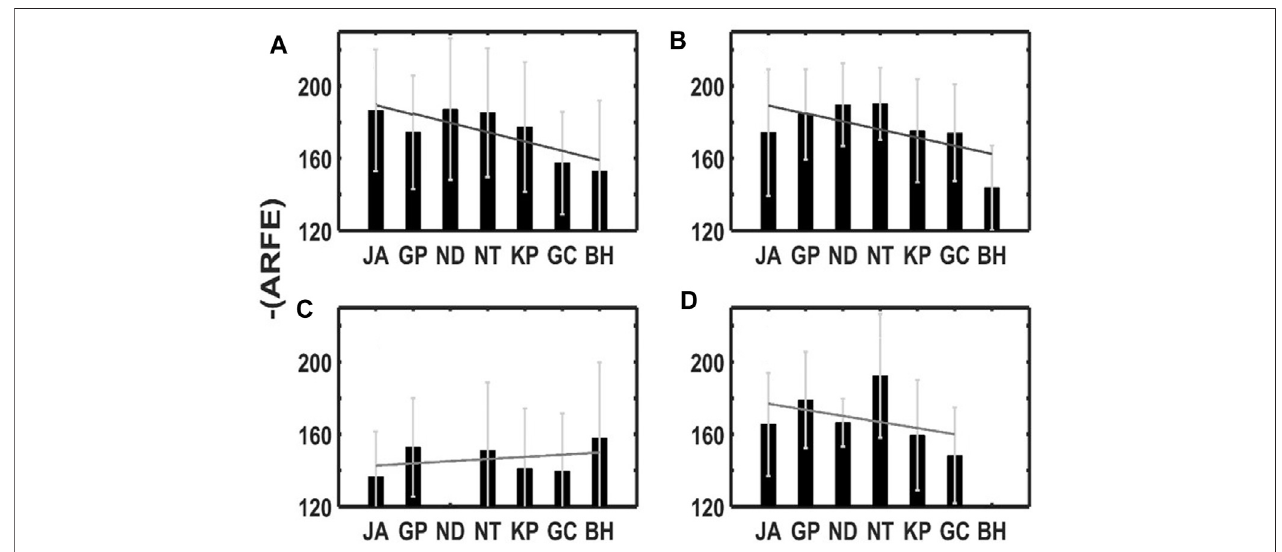
FIGURE6| VariationofARFEoverdifferentAERONETStationsfor (A) Winter, (B) Pre-monsoon, (C) Monsoon,and (D) Post-monsoon.TheARFEisde fi nedasthe radiative forcing per unit of aerosol optical depth at 550 nm estimated using simple linear regression.